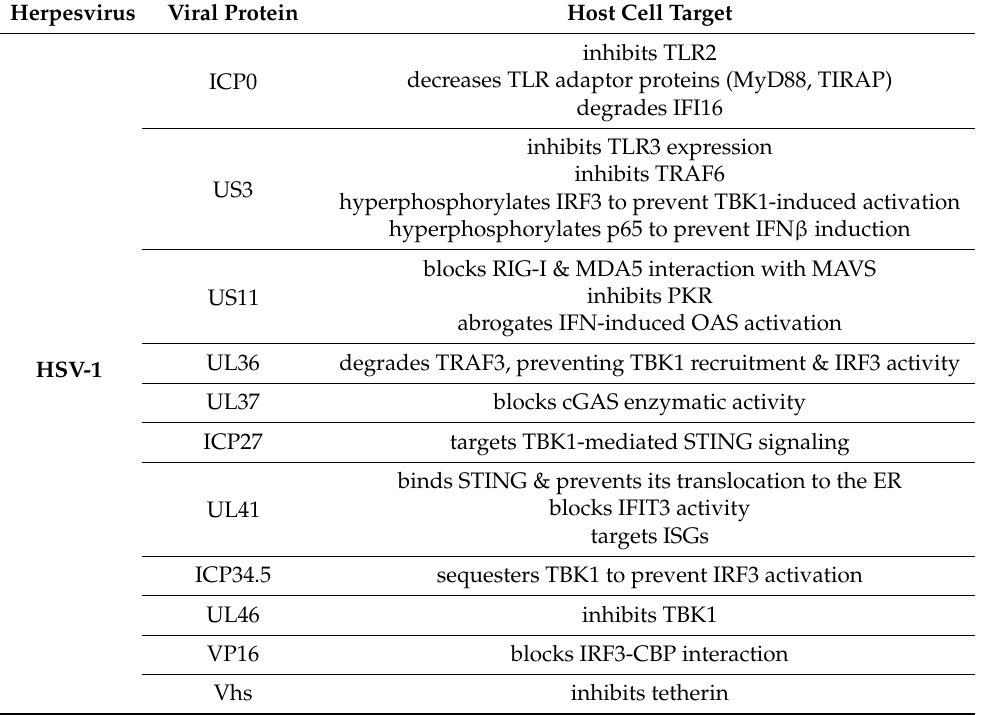
Table 1. HSV-1-encoded proteins target the host innate